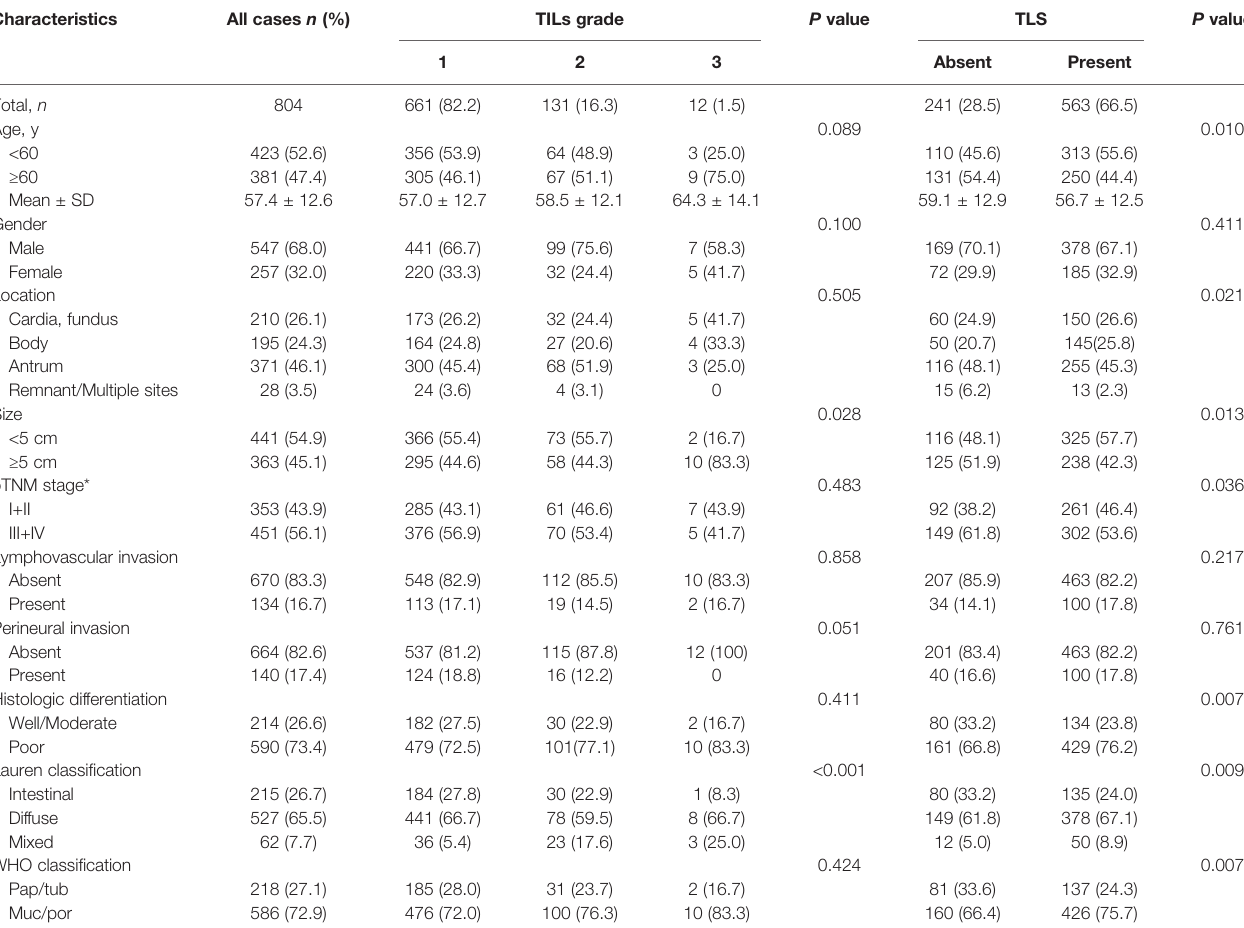
TABLE 2 | Correlation of the TILs grade and TLS with clinicopathological characteristics in EBVnGC. Characteristics